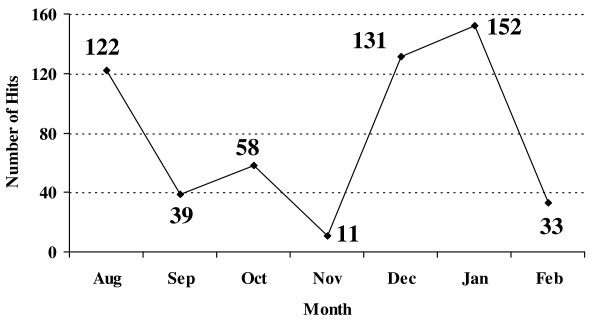
Monthly Access to NLM Server. Number of hits to NLM server by month from August 2005 to February 2006